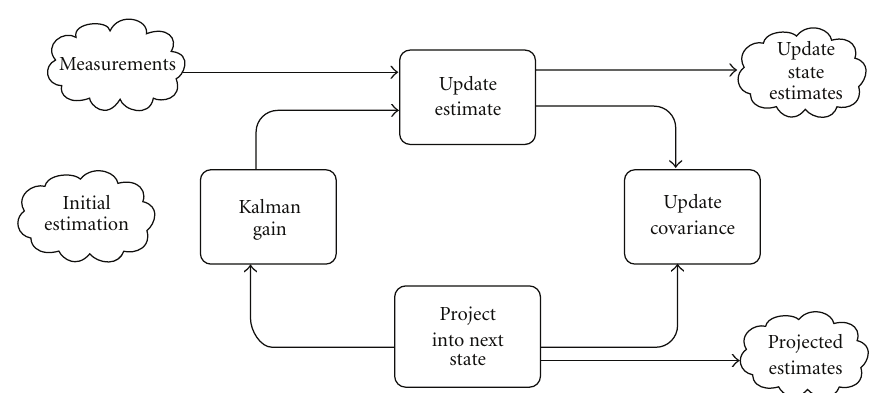
Figure 5: Kalman filter recursive algorithm flow chart.